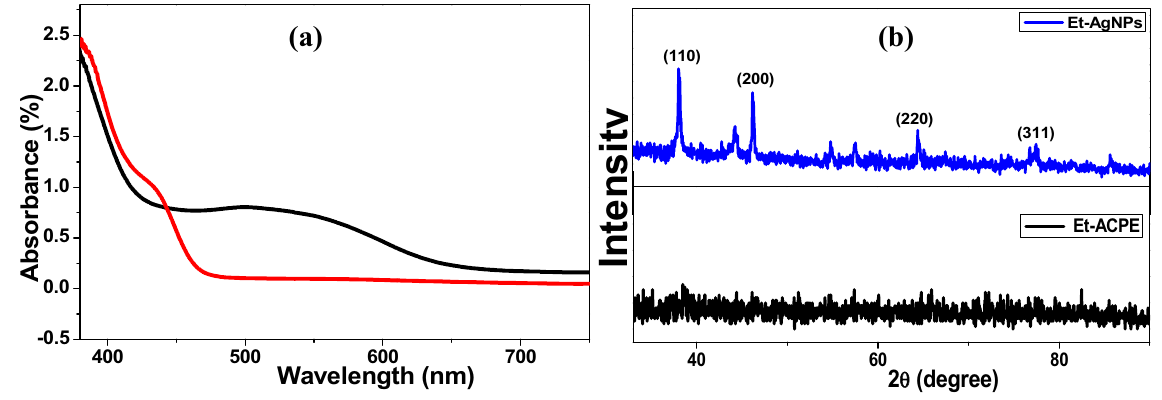
Fig. 3 a UV–Vis spectra of Et-ACPE (black) and Et-AgNPs (red) from ACPE. b X-ray diffraction pattern of Et-ACPE and Et-AgNPs from